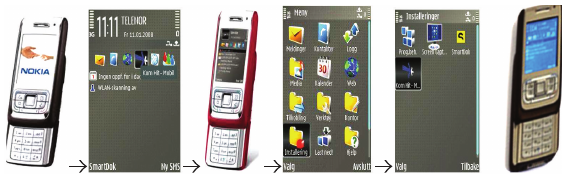
Figure 3: Examples of the user interfaces and interaction sequences.